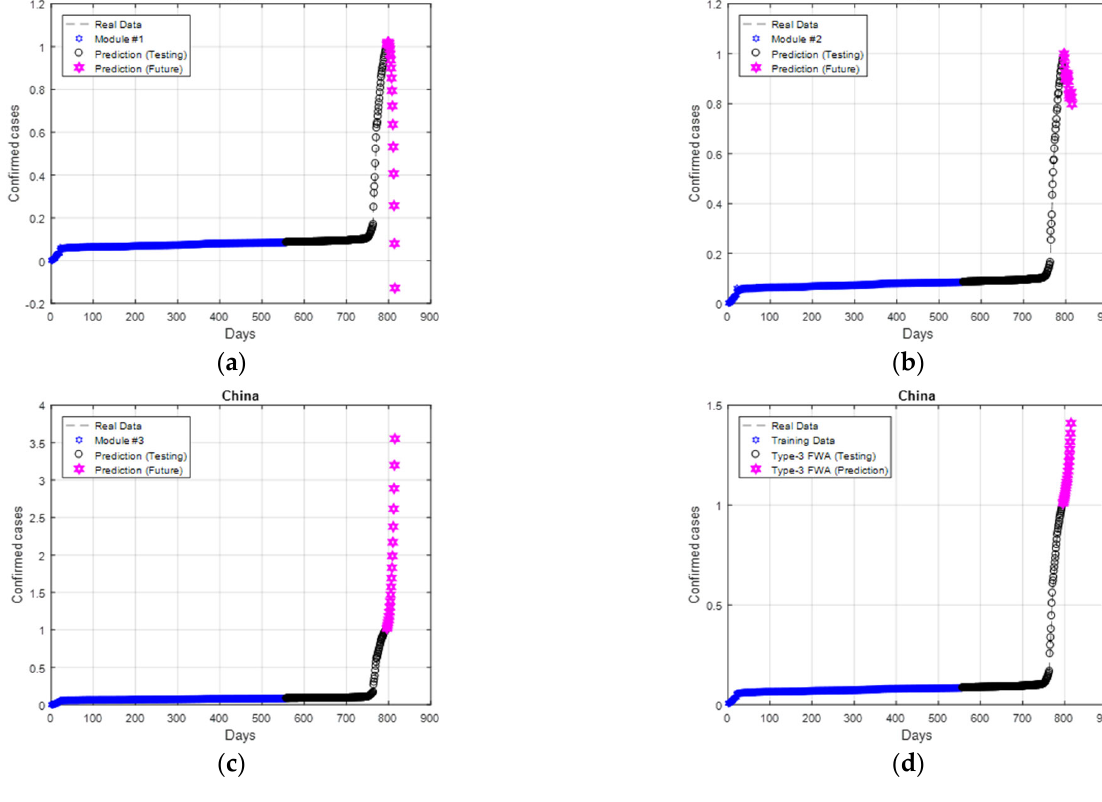
Figure 16. Individual behavior and final prediction for China: ( a ) module #1; ( b ) module #2; ( c ) module #3; ( d ) final prediction. #3; ( d ) final prediction.